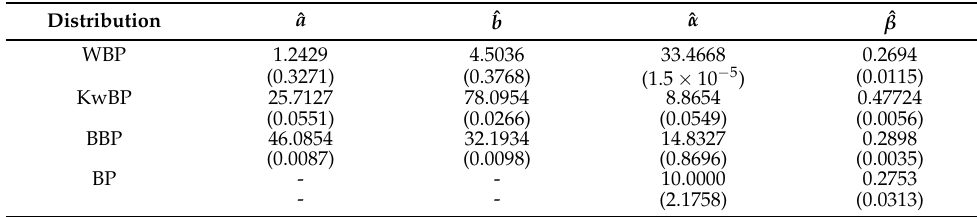
Table 3. Findings for COVID-19 data in